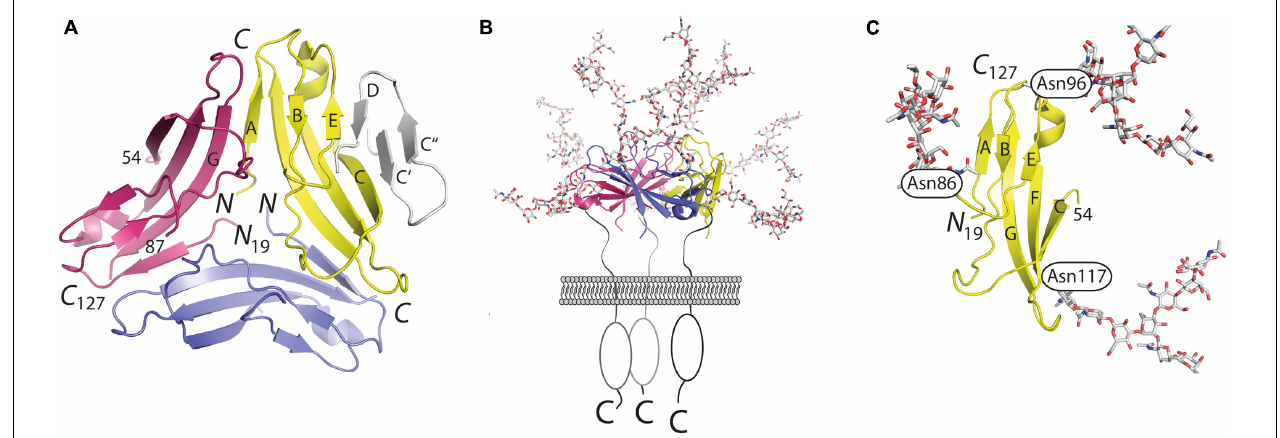
FIGURE 1 | Atomic structure of CD83. Model for the presentation of trimeric full-length CD83 on cell surfaces in comparison to the monomeric structure of shedded soluble CD83. (A) Trimeric assembly as observed in the crystal structure of hCD83. The β -strands C (cid:48) , C (cid:48)(cid:48) , and D are not visible in the crystal structure of hCD83. For illustration purpose, they are added in gray to one monomer. (B) Presentation of trimeric hCD83 on cell surfaces and (C) glycosylated monomer formed by the soluble shedded variant of CD83. The structure illustrations have been drawn with program PyMOL (The PyMOL Molecular Graphic System. WL DeLano